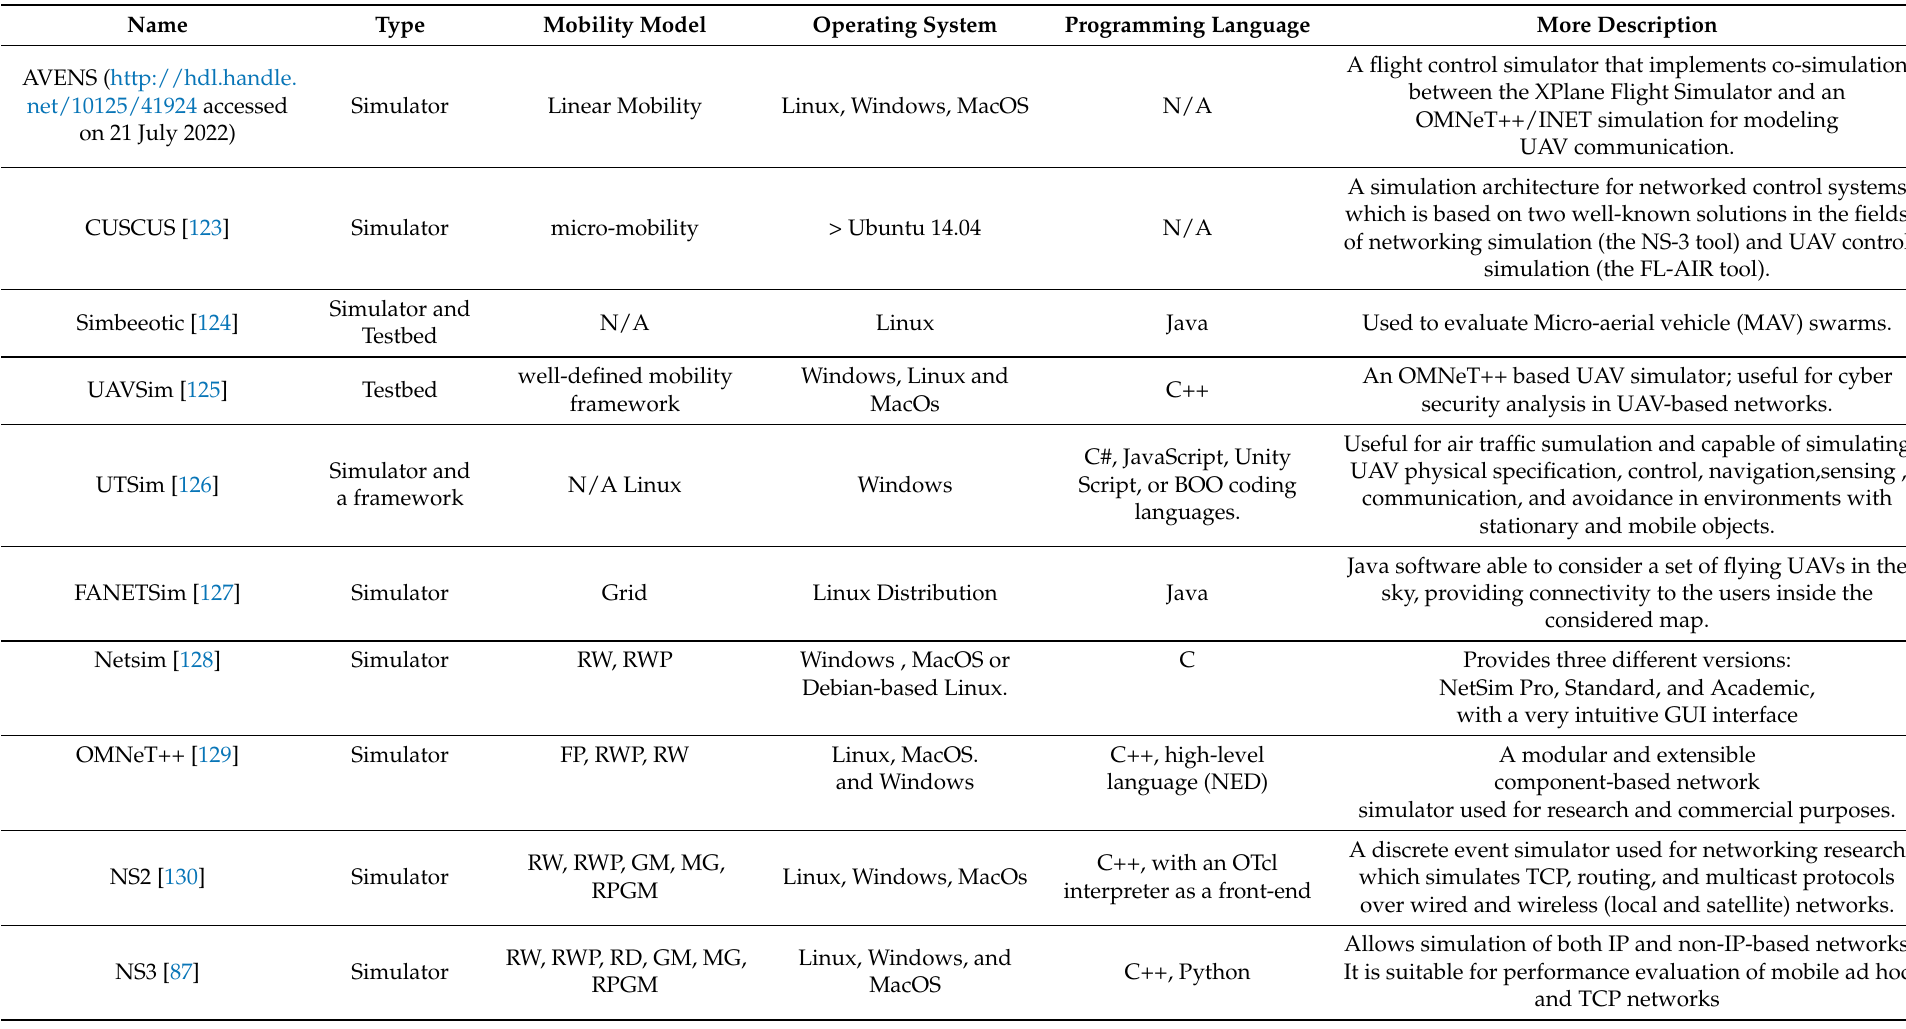
Table 2. Simulation tools and testbeds for UAV systems performance